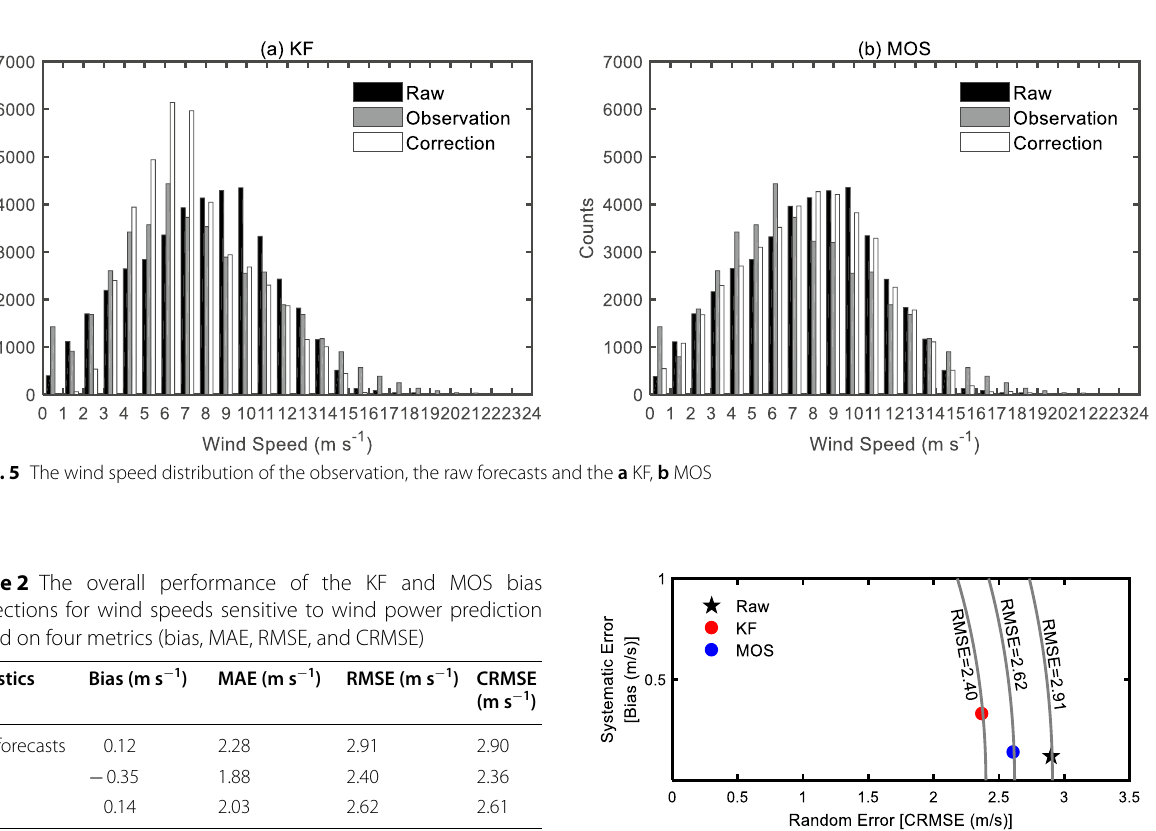
Fig. 6 Bias (m s − 1 ) as a function of CRMSE (m s − 1 ) for wind speeds sensitive to wind power prediction, showing the raw forecasts, and the KF and MOS bias